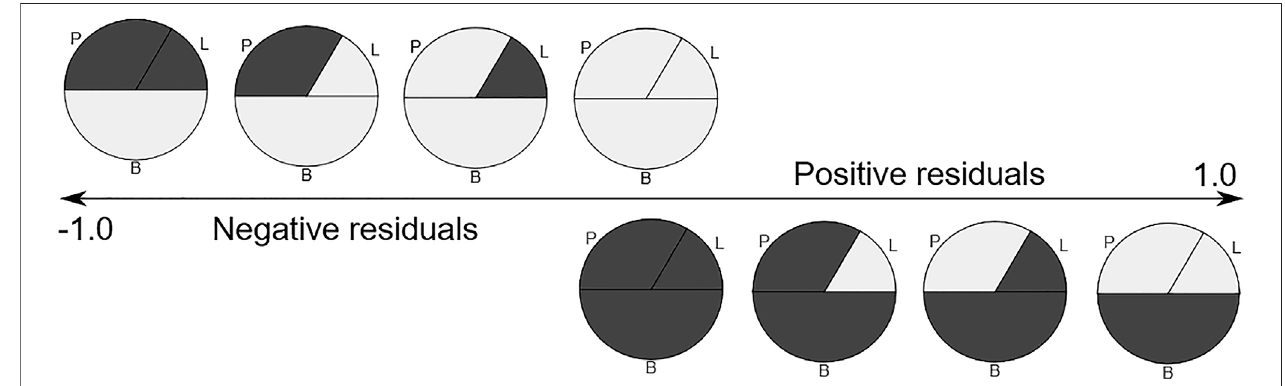
FIGURE 5 | The expected residuals of the linear model based on the methylation state of each fraction. Methylated regions are shown in dark gray. P-polymorphonuclears, L-lymphocytes, B-buffy coat.